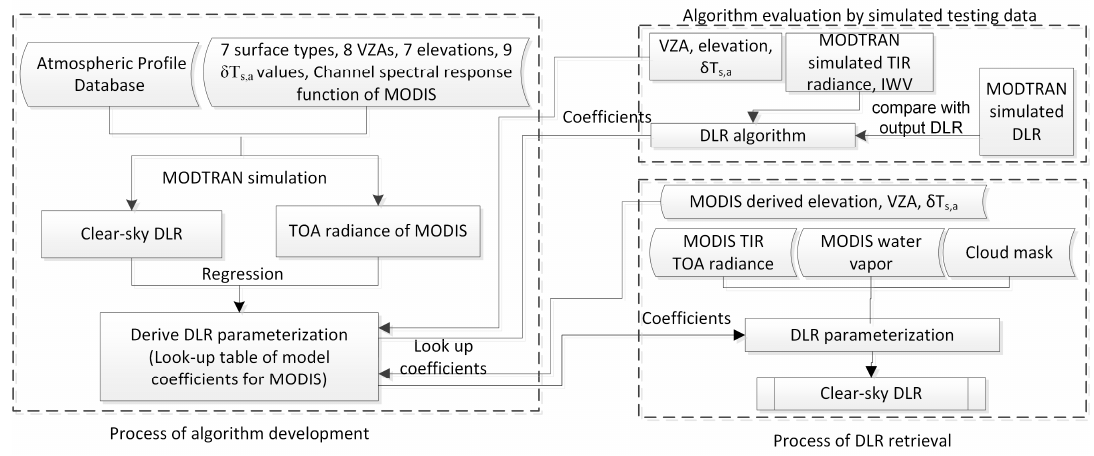
Figure 2. Flowchart of DLR modeling process and DLR derivation.